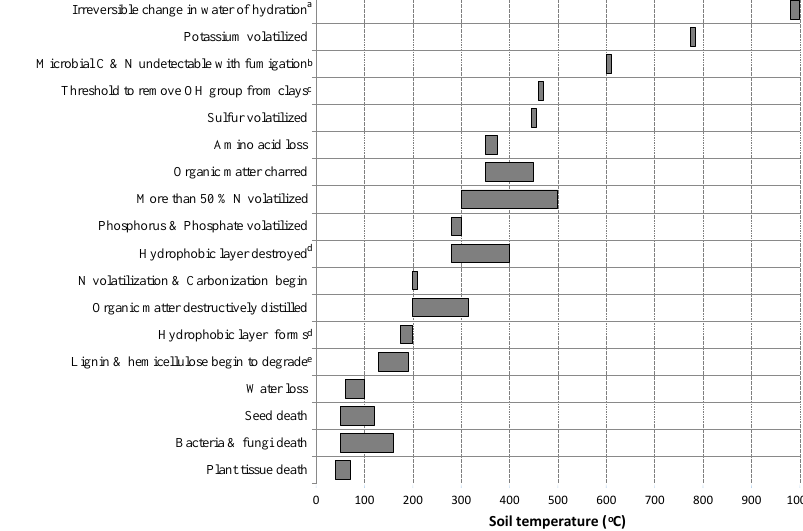
Figure 1. Temperature thresholds and ranges associated with fire heating. Figure adopted and expanded from Massman et al. (2010) ( a